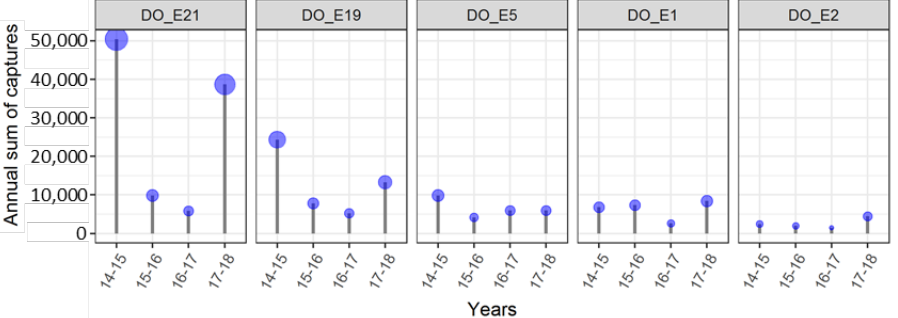
Figure 6. Yearly sum of captured individuals for five traps installed at/near the forest border. Traps DO_E21, DO_E19, DO_E1 and DO_E5 are located near the forest edge, while DO_E2 is located in the forest, 700 m from the forest border.